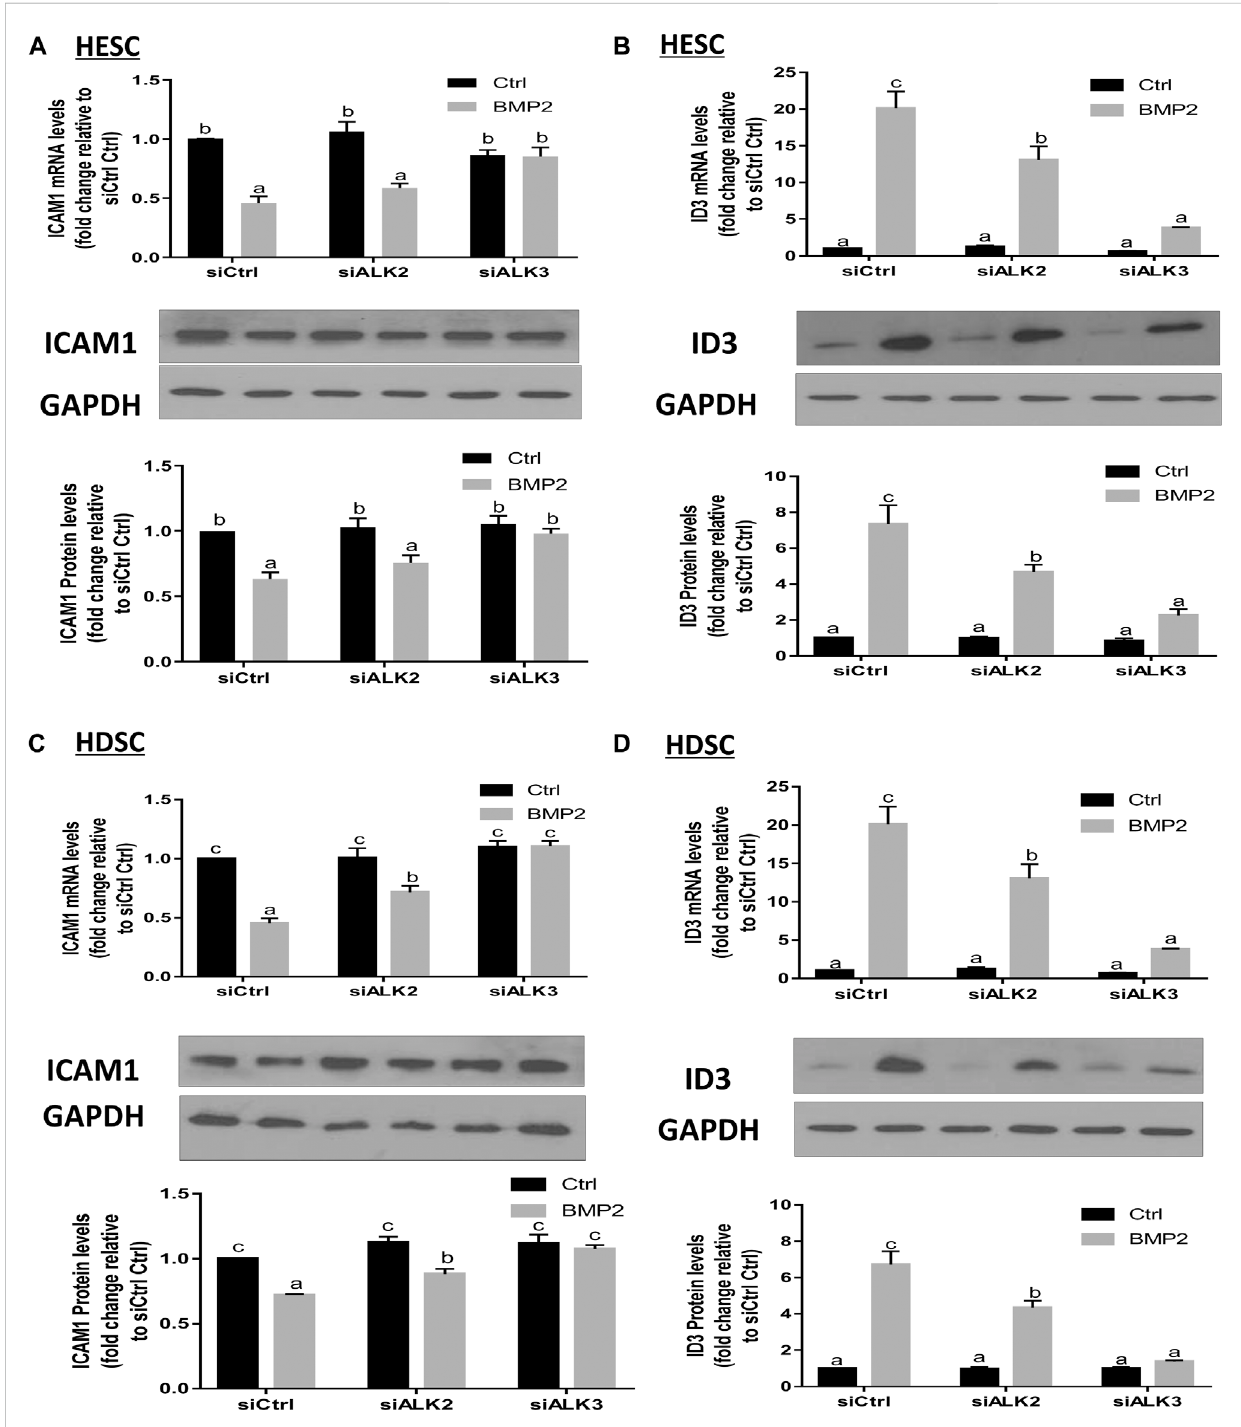
FIGURE 8 ALK3 type I mediates the BMP2-induced downregulation of ICAM1 and ID3 in HESCs and HDSCs. (A,B) HESCs were transfected with 25 nM siCtrl, siRNA targeting ALK2 (siALK2) or siRNA targeting ALK3 (siALK3) for 48 h, and the cells were then treated with Ctrl or 25 ng/mL of BMP2 for an additional 24 h.ThemRNAlevelsofICAM1 (A) andID3 (B) wereexaminedusingRT-qPCRandtheproteinlevelsofICAM1andID3wereexaminedusingWesternblot analysis. (C,D) HDSCs were transfectedwith 25 nM siCtrl,25 nM siALK2 or 25 nM siALK3 for 48 h, and the cells were then treated with Ctrl or 25 ng/ mL BMP2 for an additional 24 h. The mRNA levels of ICAM1 (C) and ID3 (D) were examined using RT-qPCR, and the protein levels of ICAM1 and ID3 were examinedusing Western blotanalysis. Theresults areexpressedas themean±S.E.M. ofatleastthreeindependent experiments.Differentlettersindicate signi fi cant a difference ( p <